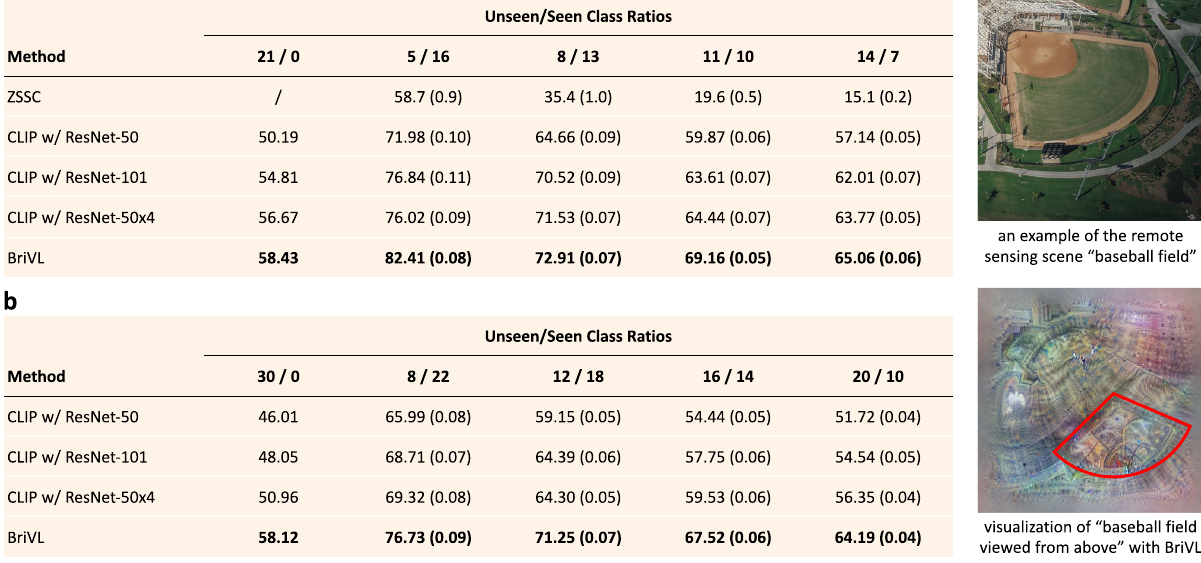
Fig. 4 Zero-shot remote sensing scene classi fi cation results. a Zero-shot accuracies (%) on UCM with different unseen/seen class ratios. b Zero-shot accuracies (%) on AID with different unseen/seen class ratios. c Visualizations of “ baseball fi eld ” . For ( a ) and ( b ), we report standard deviations in brackets over 25 random splits. Highest results in ( a ) and ( b ) are highlighted in